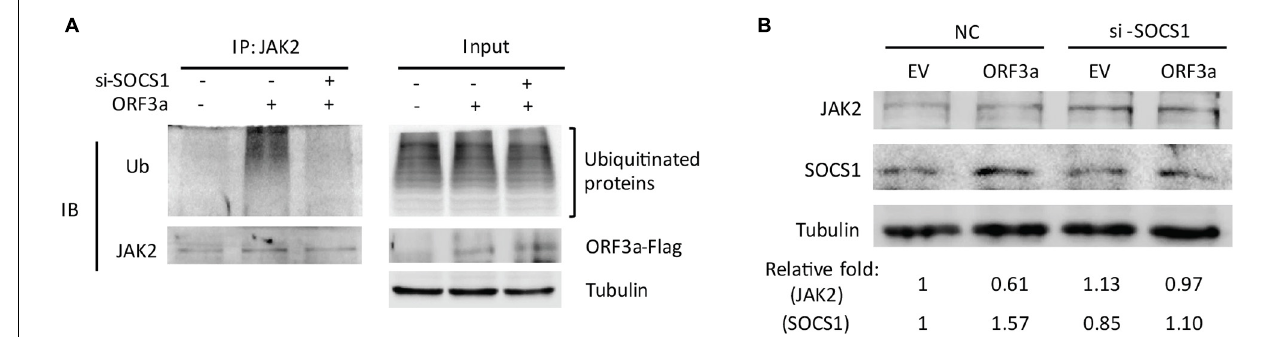
FIGURE 6 | Silencing of SOCS1 diminishes ORF3a-induced JAK2 degradation. (A) Knockdown of SOCS1 lessens the elevation of JAK2 ubiquitination induced by ORF3a, while ubiquitination levels of total proteins in input were similar. Cells were cotransfected with empty vector (EV) or ORF3a plasmid along with NC or si-SOCS1. Thirty-six hours later, the cells were harvested the whole cell lysate (input) with IP lysis buffer. IP was conducted with JAK2 antibody. The input and IP products were detected by immunoblotting with Ub, JAK2, Flag, and tubulin antibodies. (B) Silencing of SOCS1 reverses ORF3a-induced JAK2 reduction. Cells were cotransfected with EV or ORF3a and NC or si-SOCS1, and at 36 h after transfection, harvested for immunoblotting. Relative levels of proteins are shown as folds below the images after normalization with tubulin.